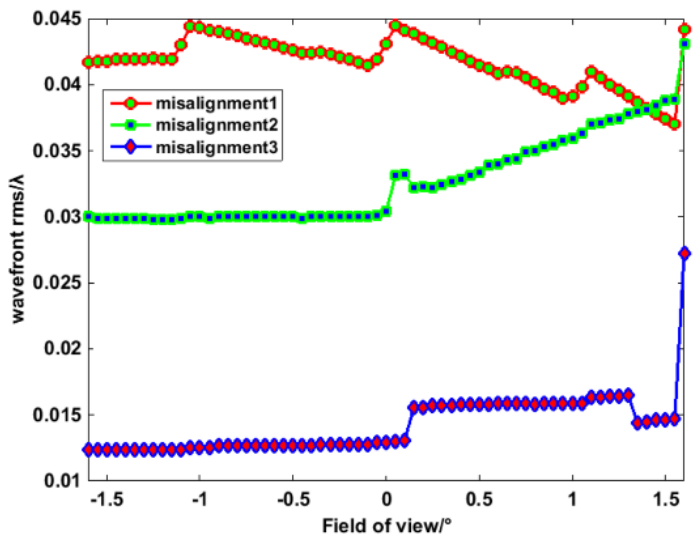
Figure 3. Residual wavefront errors in different fields of view for three misalignments.